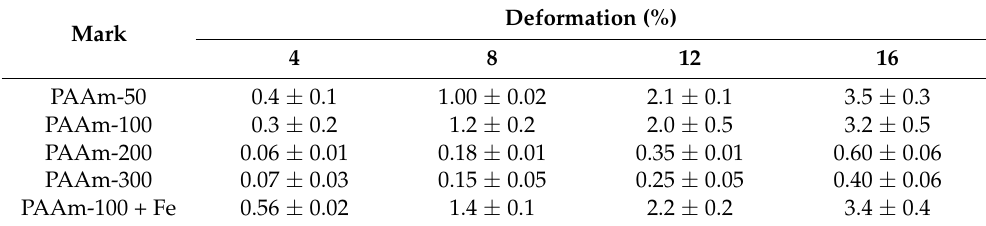
Table 2. Tension (in N/m 2 ) obtained at different deformation in the tested samples. The mean values ( n = 4) and standard deviations are shown. The concentration of iron oxide MNPs in ferrogel was 0.34 wt.%. Mark